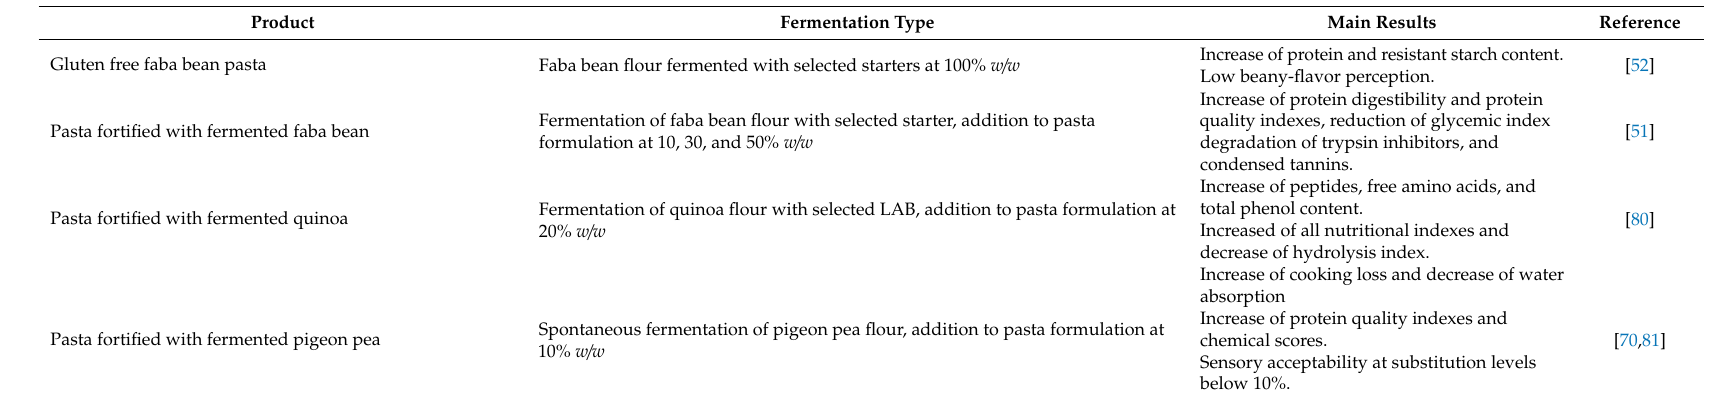
Table 2. Non-exhaustive survey of the pasta products including fermentation step of non-wheat flours mixtures. The main nutritional and functional improvements, and the e ff ects on technological and sensory properties, in comparison to conventional pasta, are